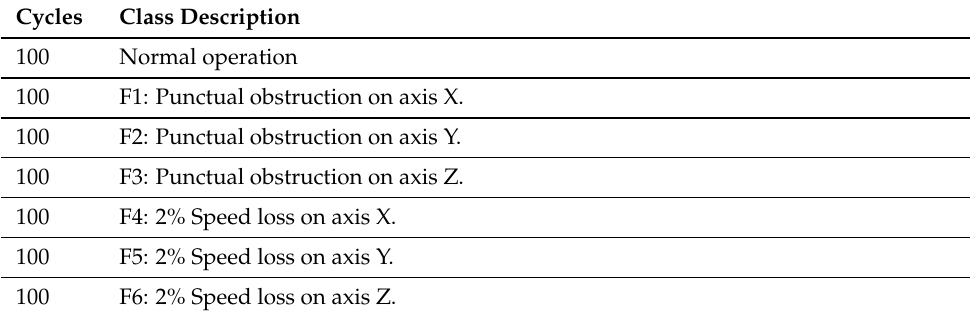
Table 1. Dataset classes and respective numbers of